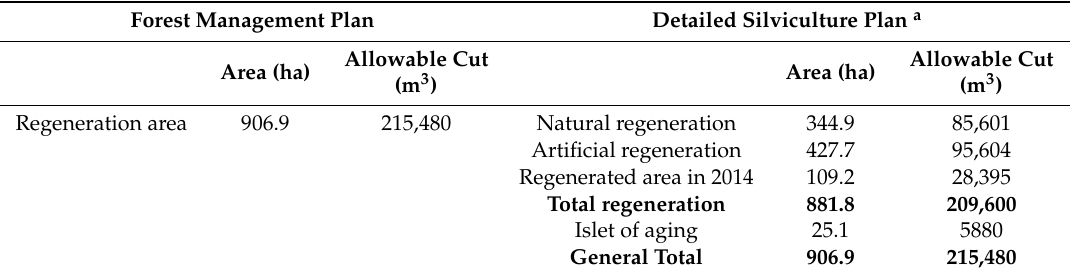
Table 9. Regeneration data in the forest management plan and detailed silviculture plan.